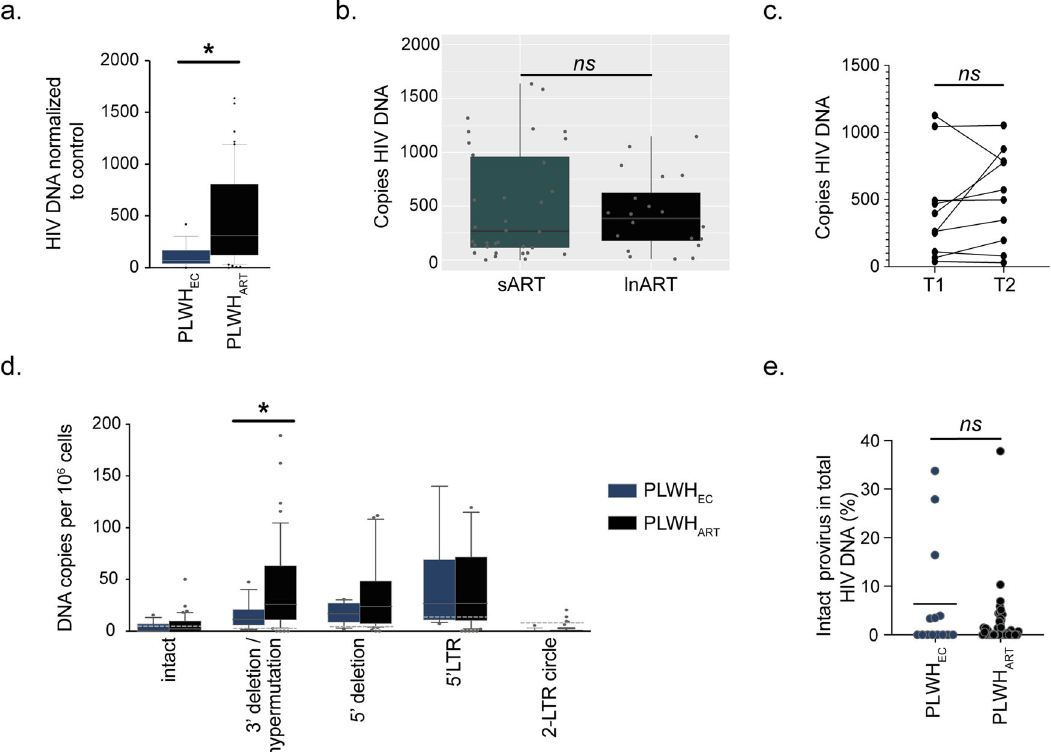
Fig. 4 The HIV-1 reservoir in PLWH EC is distinct from PLWH ART . a Quanti fi ed total HIV-1 DNA in peripheral blood mononuclear cells from PLWH EC ( n = 14) and PLWH ART ( n = 54). b Total HIV-1 DNA in short-term ART (sART, <10 yrs, n = 34) compared to long-term ART (lnART, >10 yrs, n = 20) in people living with HIV-1 on suppressive therapy. c Total HIV-1 DNA in longitudinal data from HIV-1 infected individuals (timepoint 1 (T1), n = 10 and timepoint 2 (T2), n = 10). d Box and Whisker plot show the distribution of integrated HIV-1 DNA copies per 10 6 PBMCs in PLWH ART ( n = 54) and PLWH EC ( n = 14) with whiskers representing the 10 – 90 percentile. The median is represented by the line inside the box. The dotted line marks the background represented by HC samples. e Percentage of intact provirus out of total HIV-1 DNA detected. Statistical signi fi cance was determined using two-tailed Mann – Whitney U-test (signi fi cance level p < 0.05, with *<0.05, **<0.001) and represented as median using 95% CI. All individual samples were run in technical